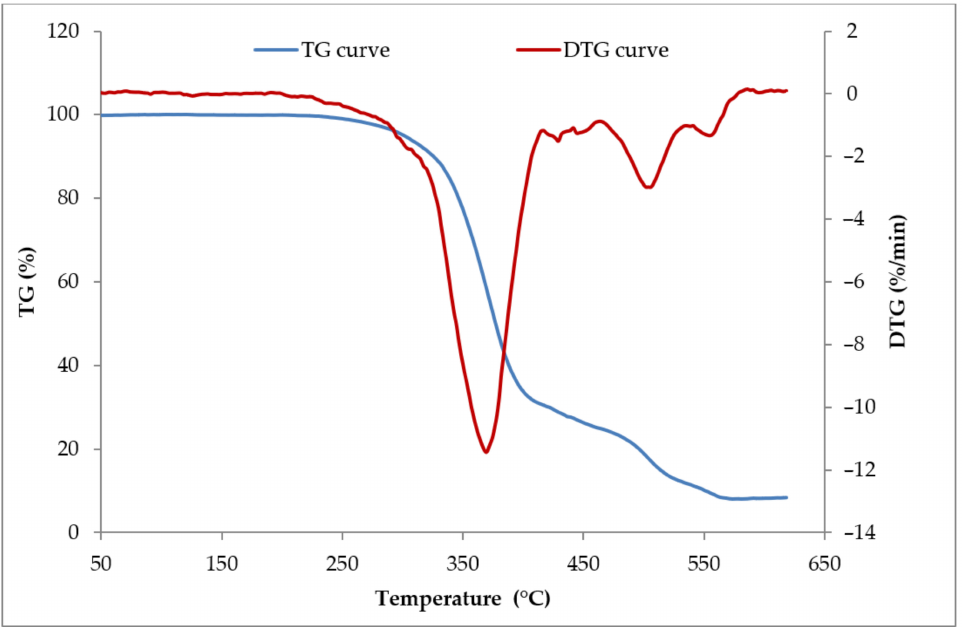
Figure 18. The TG and DTG curves of vulcanizates filled with 30 phr of Straw:Carbon